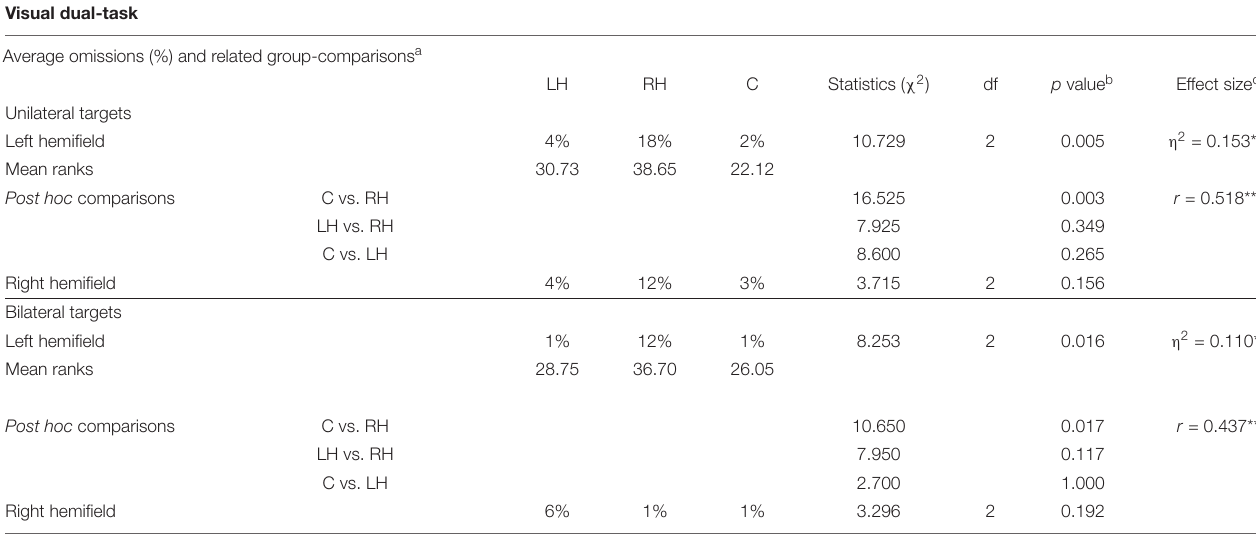
TABLE 5 | Average omissions in the visual dual-tasks, and related group comparisons, shown separately for unilateral/bilateral trials and for each hemifield. Visual dual-task